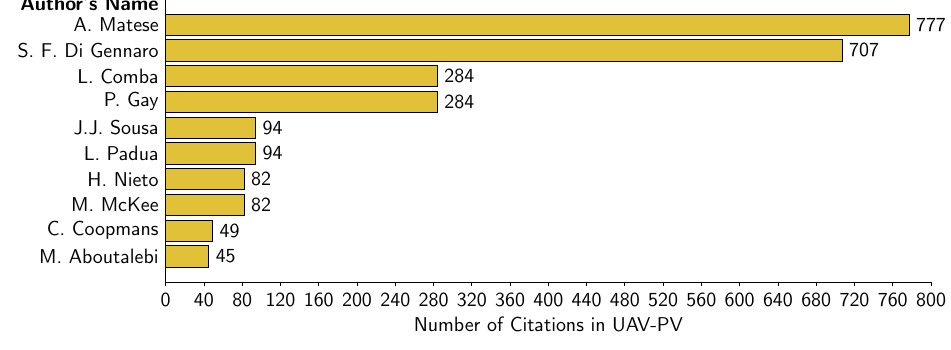
Figure 16. Most cited authors on adopting UAV-PV.